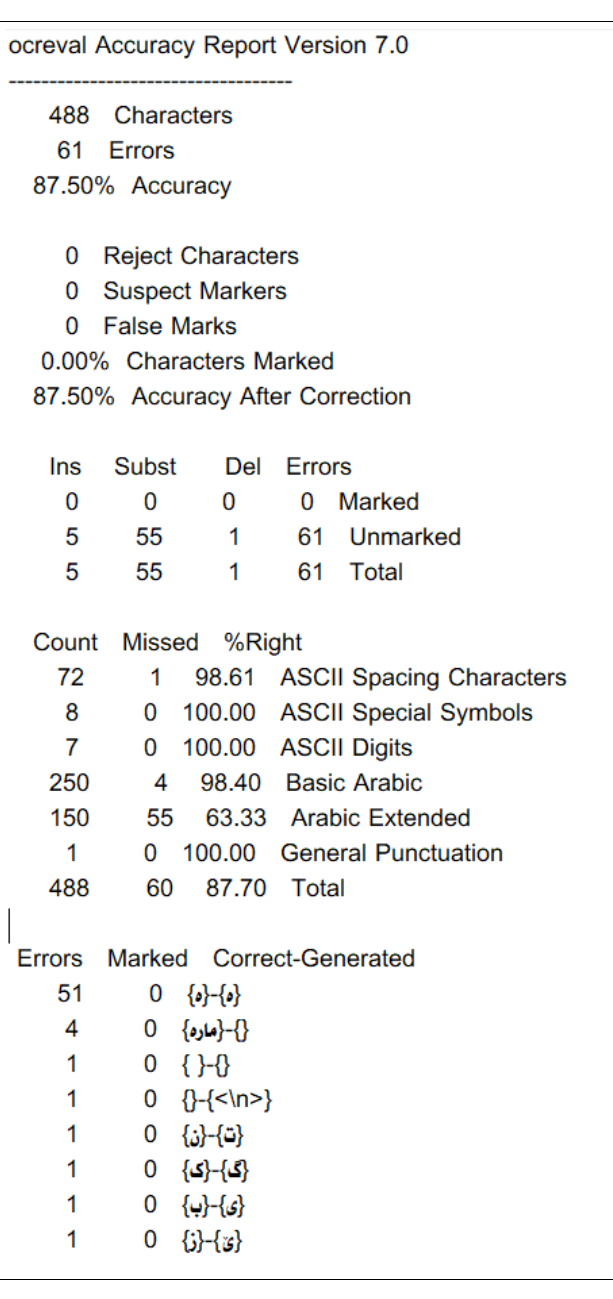
Figure 8. Detailed report on actual Court’s document